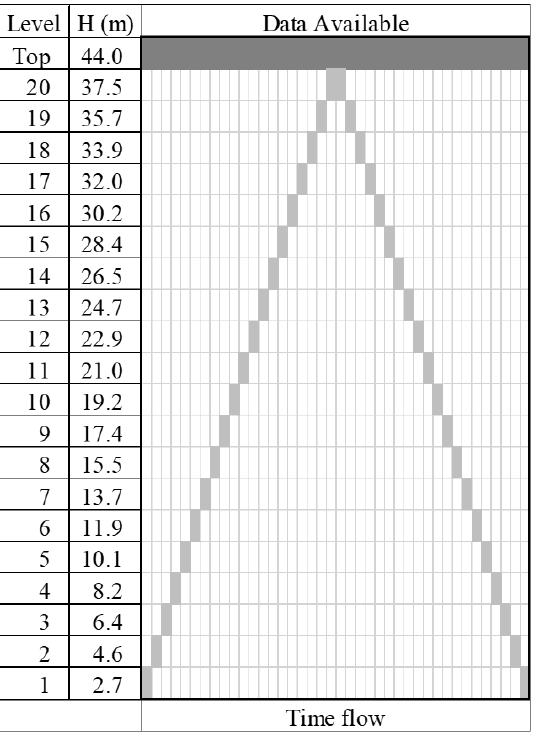
Figure A2. Data collected at each level by the line quantum sensor (gray) and the top-of-canopy sensor (dark gray) for Eq. (A2) for a single campaign event (i.e., one cycle up and down the